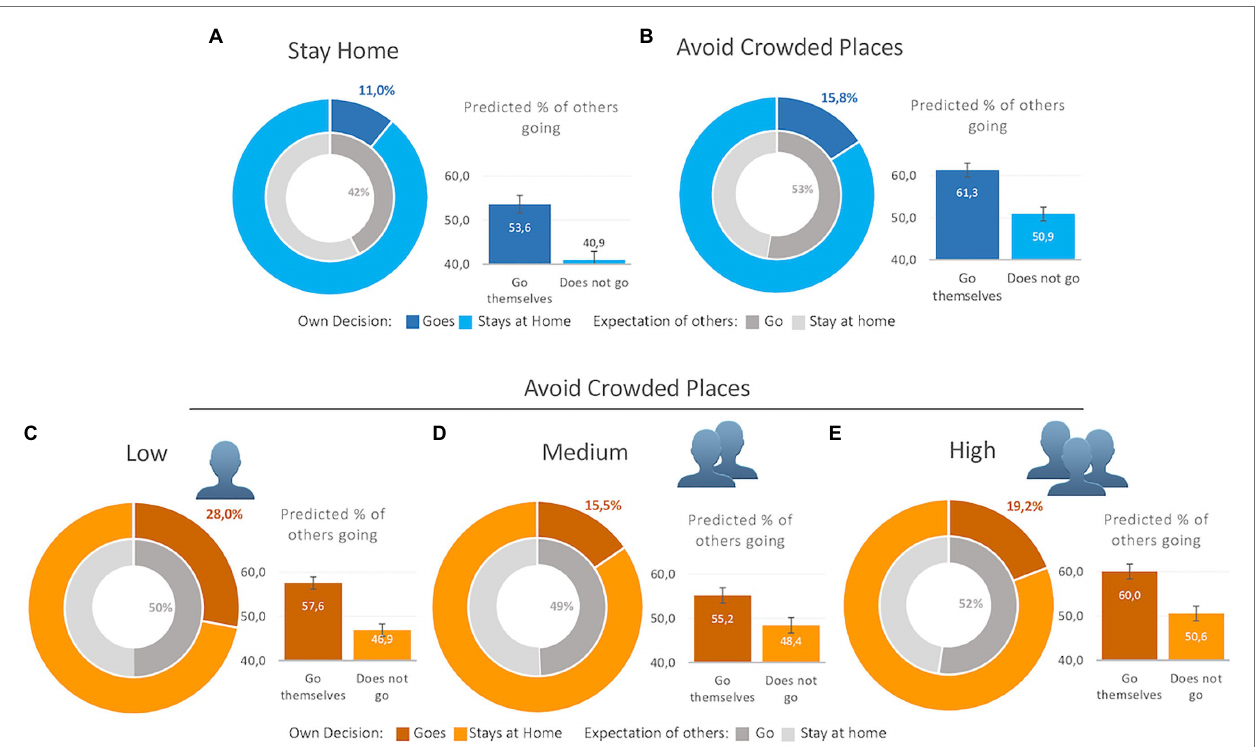
FIGURE 1 | Statistics of intention to visit the crowded place. Note: The outer ring of the graph shows the percentage of respondents indicating to visit the crowded place, for each context. The inner ring shows the average expected percentage of others to visit the crowded place. The bar graph shows the same expected percentage of others to visit a crowded place, but split by respondents that indicate to go themselves versus respondents that indicate to stay at home. (A) Shows the metrics under the policy “stay home” without any further context. (B) Shows the same metrics but in the condition of “avoid crowded places.” (C–E) Show the graphics in this same condition, but each for a different level of crowdedness on the stress (low, medium, and high crowdedness, respectively). For an overview of the difference testing, see Tables 3 and 4